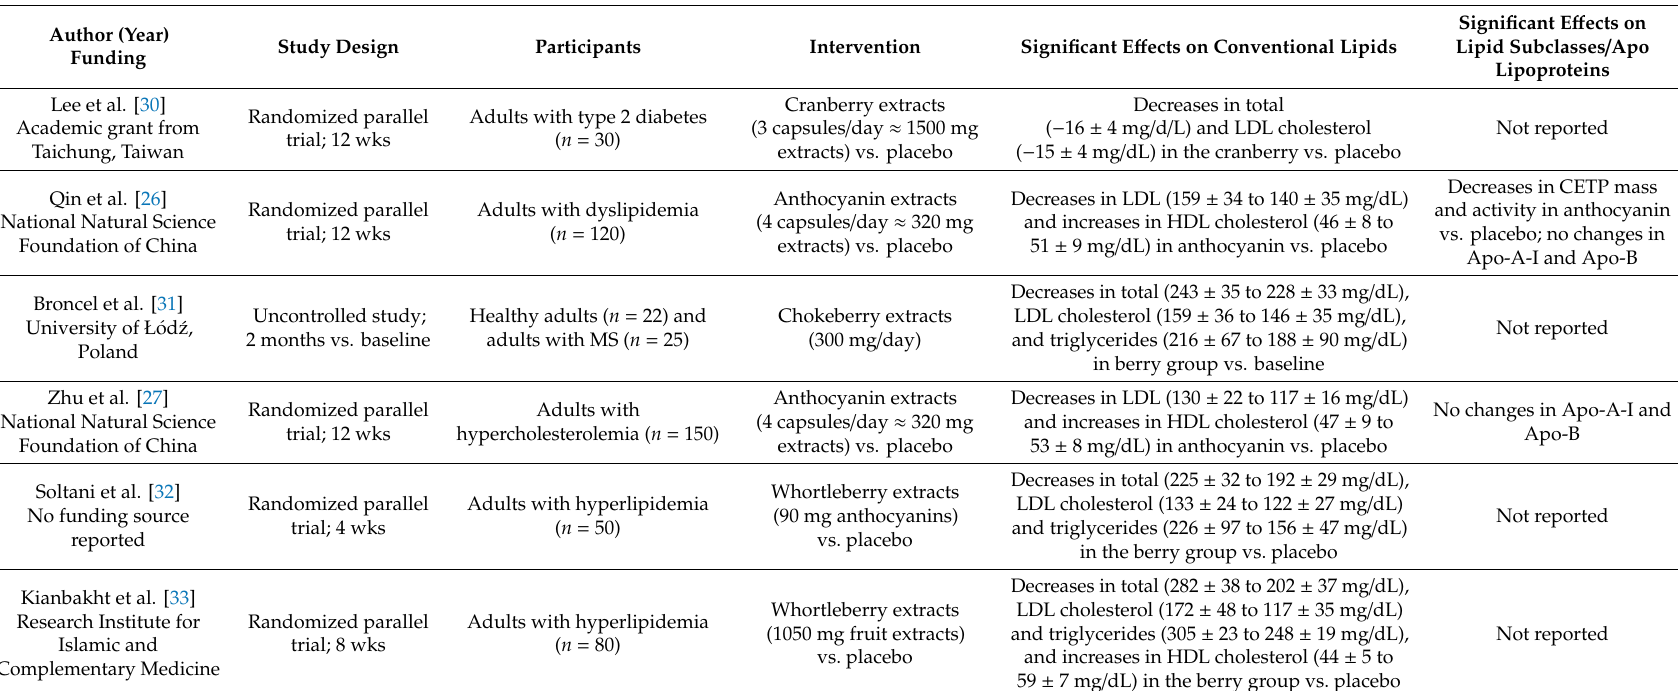
Table 1. E ff ects of berry bioactive compound extracts on serum lipids: clinical